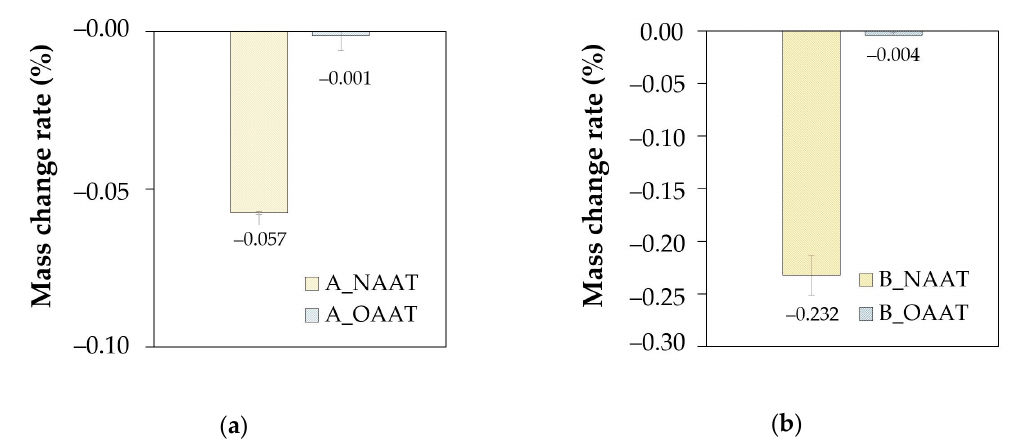
Figure 4. Mass change rate (after NAAT and OAAT aging procedure): ( a ) binder A; ( b ) binder B.